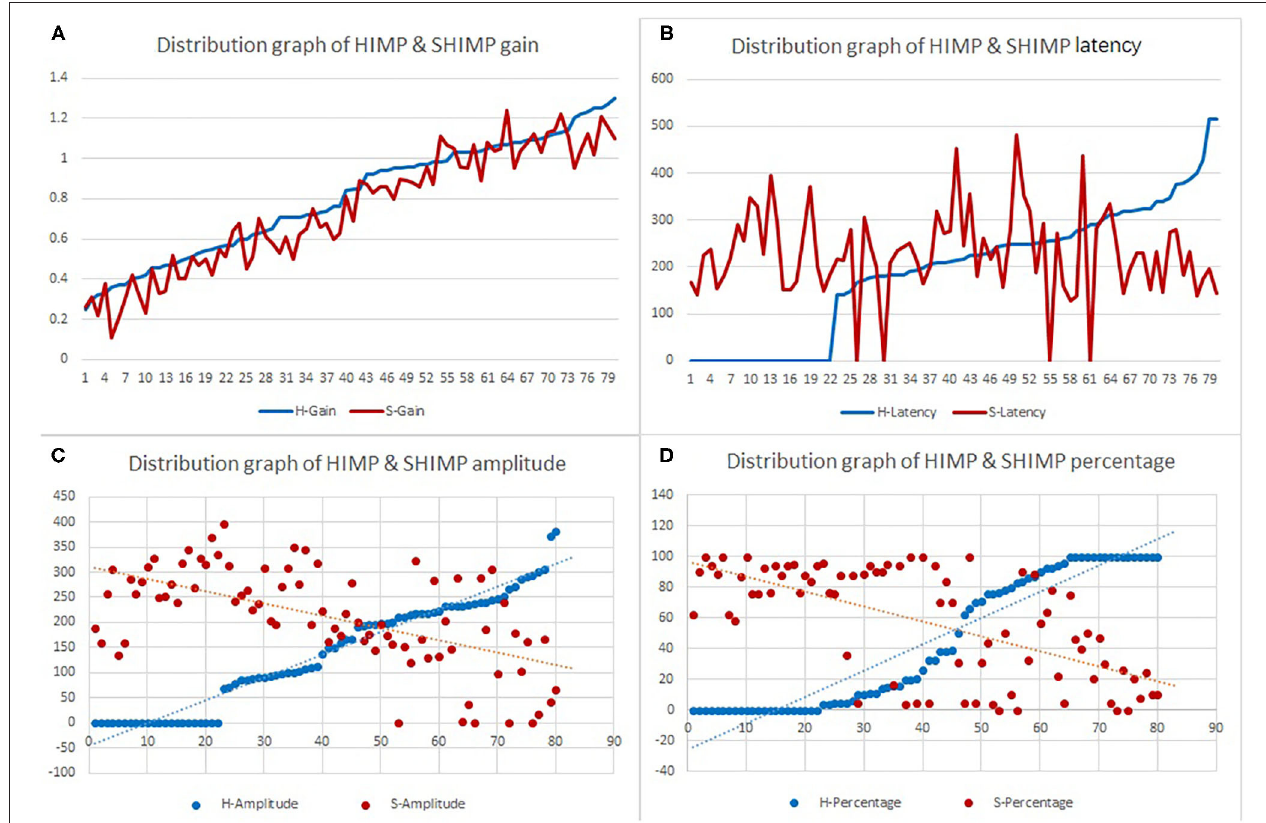
FIGURE 5 | Scatter plot demonstrating the associations between HIMP and SHIMP parameters in all participants. (A) Gain between HIMP and SHIMP were highly positively correlated ( r = 0.957, p = 0.000). (B) HIMP and SHIMP latencies were not correlated ( r = 0.077, p = 0.499). (C) Saccade amplitudes between HIMP and SHIMP were strongly negatively correlated ( r = − 0.637, p = 0.000), as were the (D) percentages of overt saccades between HIMP and SHIMP ( r = − 0.631, p = 0.000).